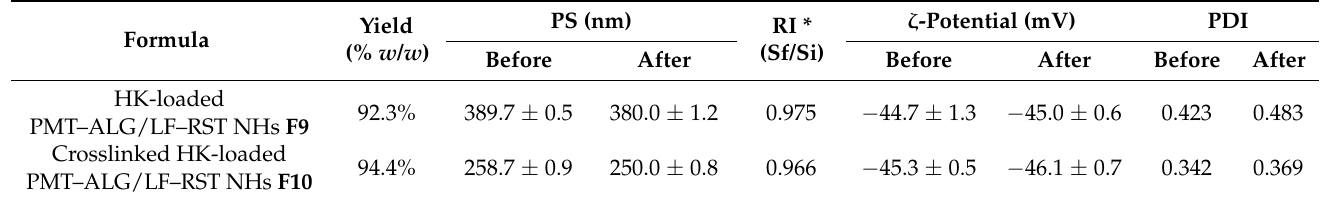
Table 3. Freeze-drying effect on the PS, zeta potential and yield of F9 and F10 NHs ( n =